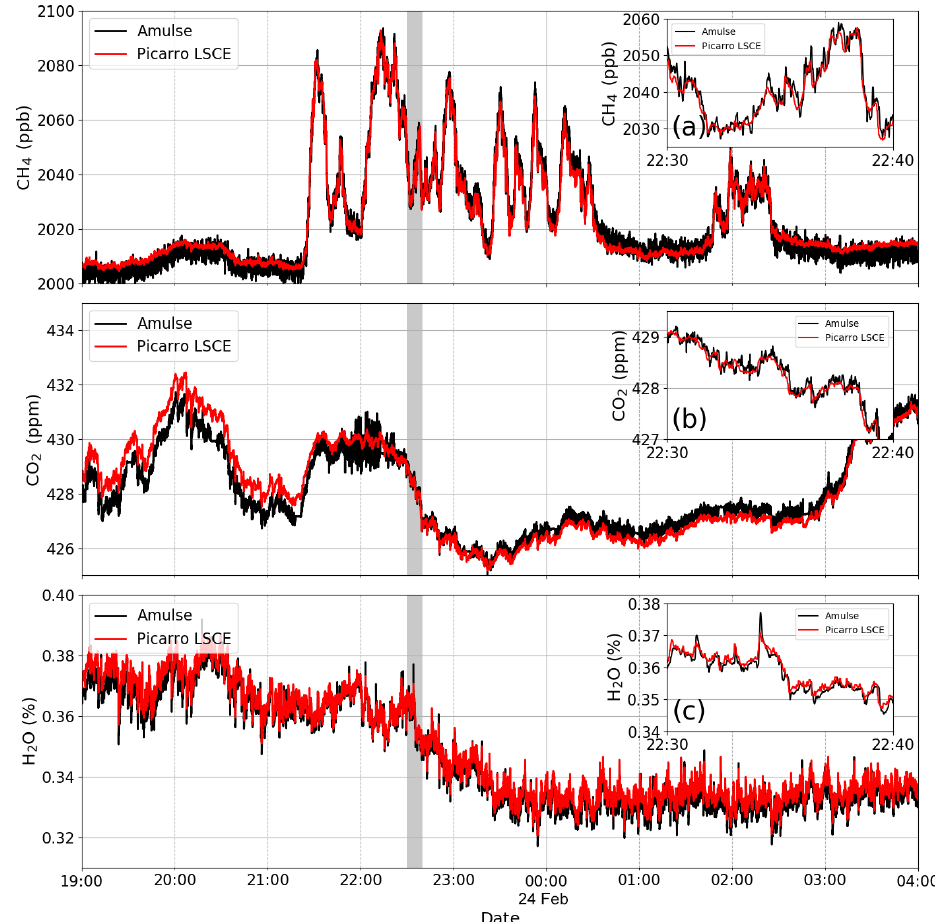
Figure 1. Intercomparison between AMULSE’s concentration (in black) and Picarro’s concentration calibrated with WMO gases (in red) over 9h for CO 2 , CH 4 and H 2 O. Grey areas correspond to the zoomed-in views. Time is in UTC.